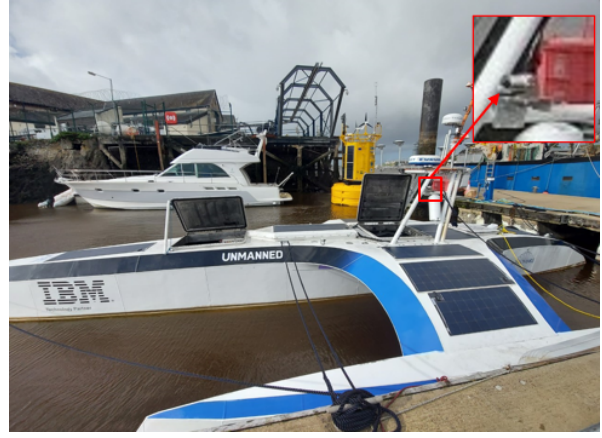
Figure 2. Camera setup on the MAS. There is a Vicon security camera on both the port and starboard sides of the boat, 2.25 m above sea level, facing at a 90-degree angle to the sea. The port-side camera is visible in this image, as highlighted in the box drawn on the image.